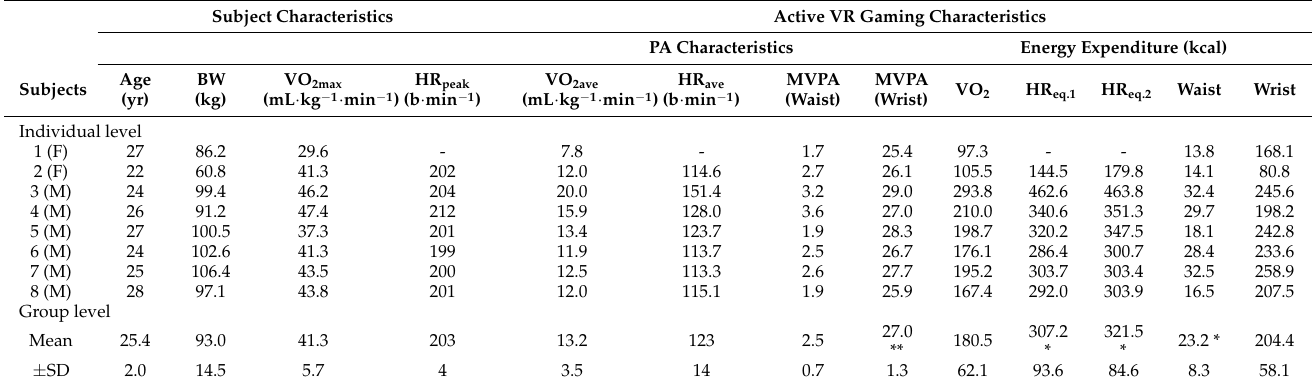
Table 2. Physiological and active VR gaming characteristics at an individual and a group level.